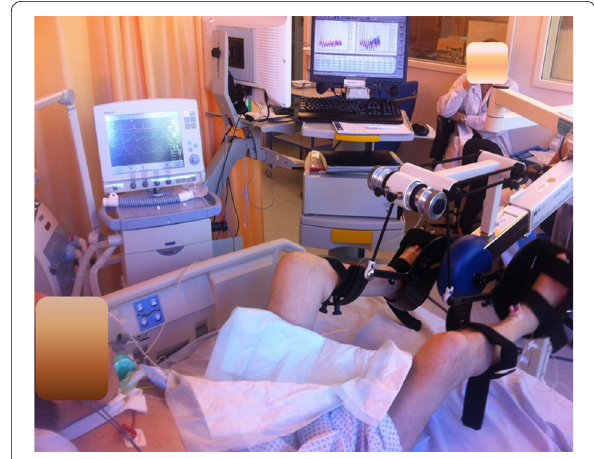
Fig. 1 Example of a patient ventilated with Neurally Adjusted Ventila‑ tor Assist (NAVA) while performing exercise with the cycle